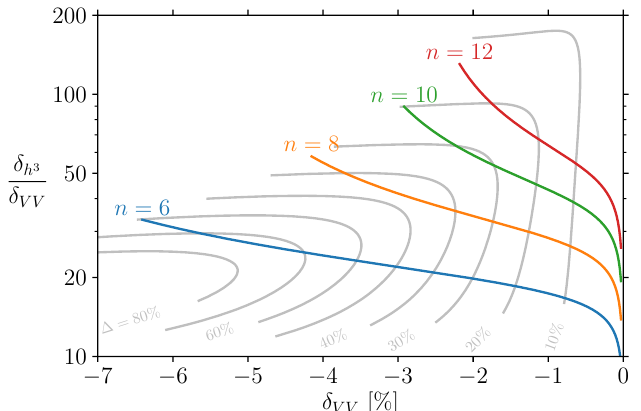
Figure 5 . The ratio of self-coupling to hV V corrections in the Gegenbauer’s Twin model of [4], for several values of n . In the empty upper-left corner of the figure, the SM vacuum is no longer the global minimum of the potential and therefore becomes unstable. Grey contours show the fine-tuning of the Higgs mass and vacuum expectation value in this